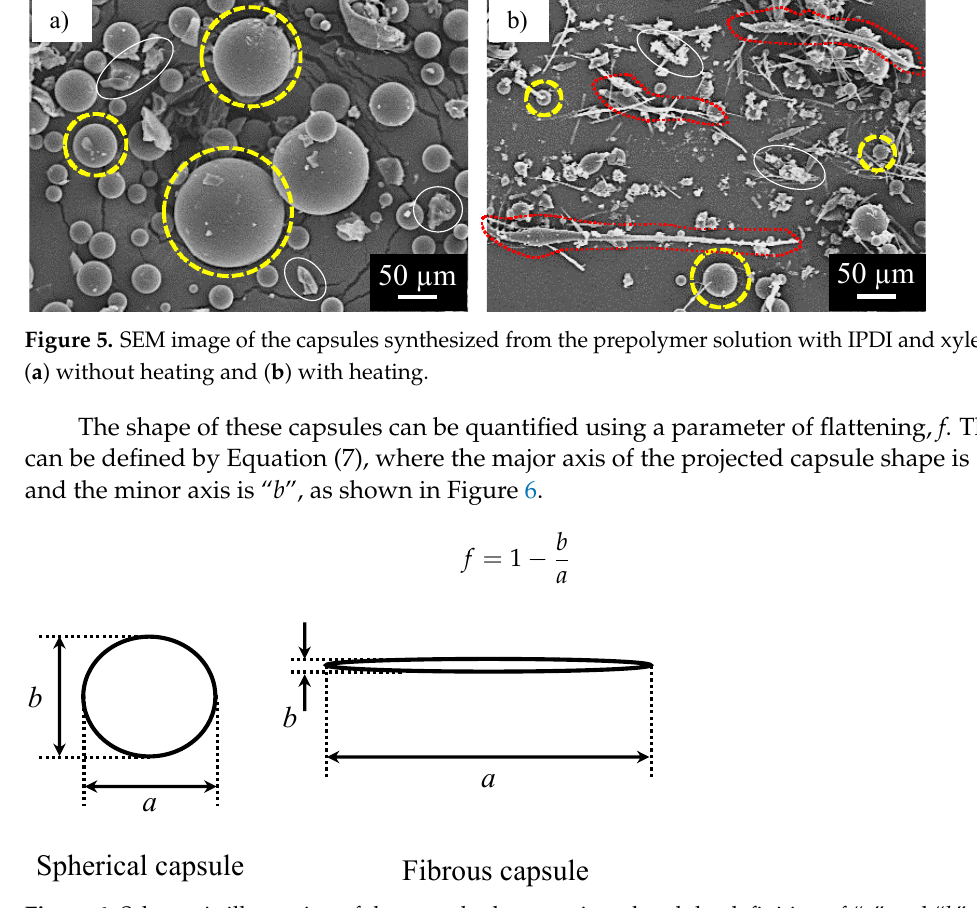
Figure 7. Fla tt ening factor distribution of the capsules synthesized from the prepolymer without and with heating .